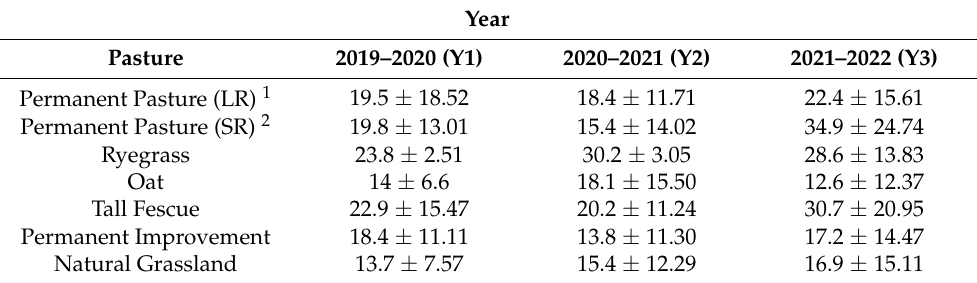
Table 5. Forage growth for each type of pasture (average ± s.d.) and year in the ‘Palo a Pique’ pasture–crop rotations long-term experiment in Treinta y Tres,